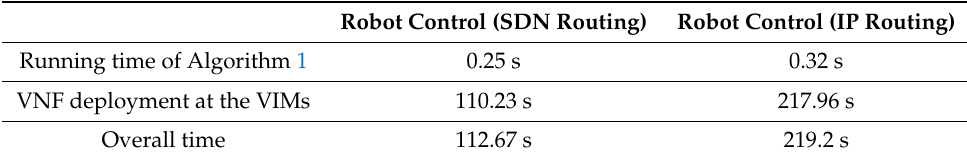
Table 6. Sandbox experiments of our prototype implementation of Algorithm 1 [19].